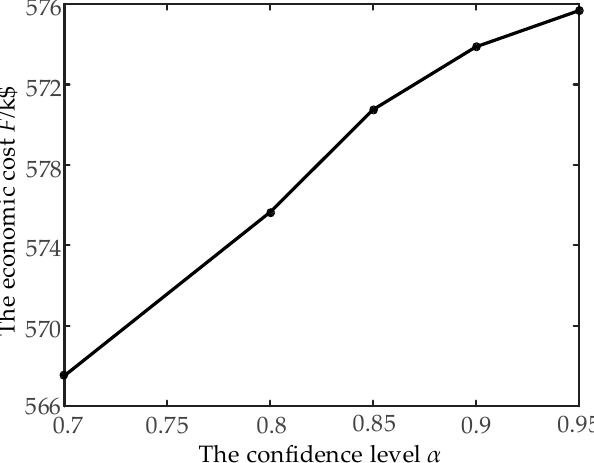
Figure 9. The economic costs with different confidence levels.